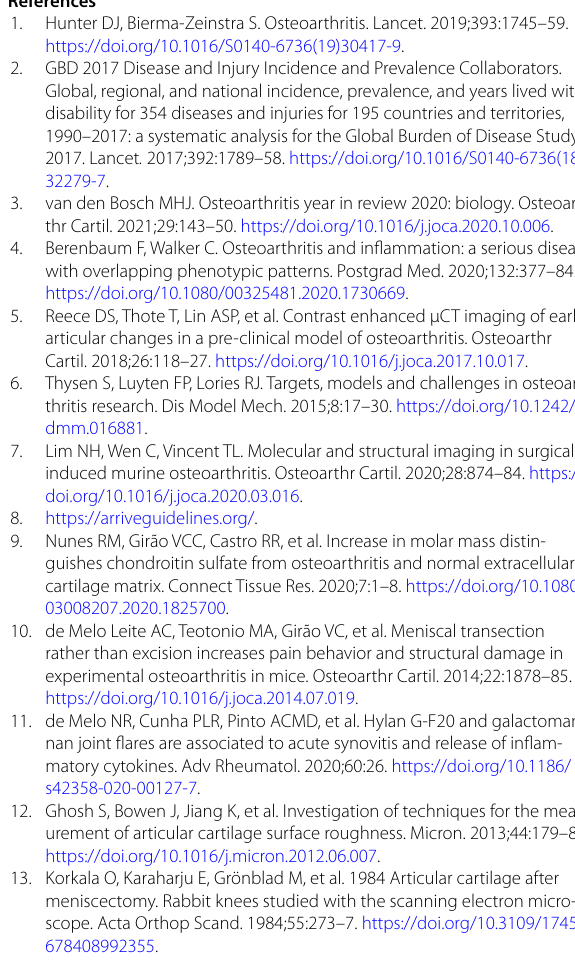
4 animals/group; difference between medians assessed using Kruskal– =